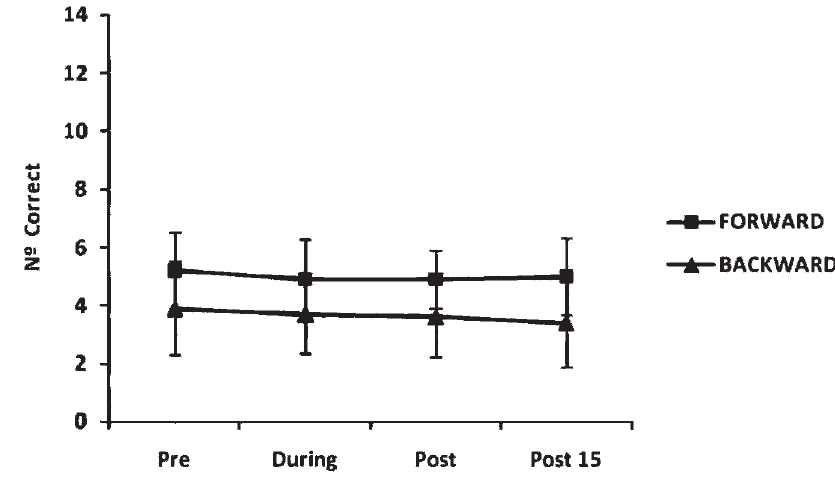
Figure 1 - Comparison of the performance in the Digit Span Test among different time points (means ¡ SD).